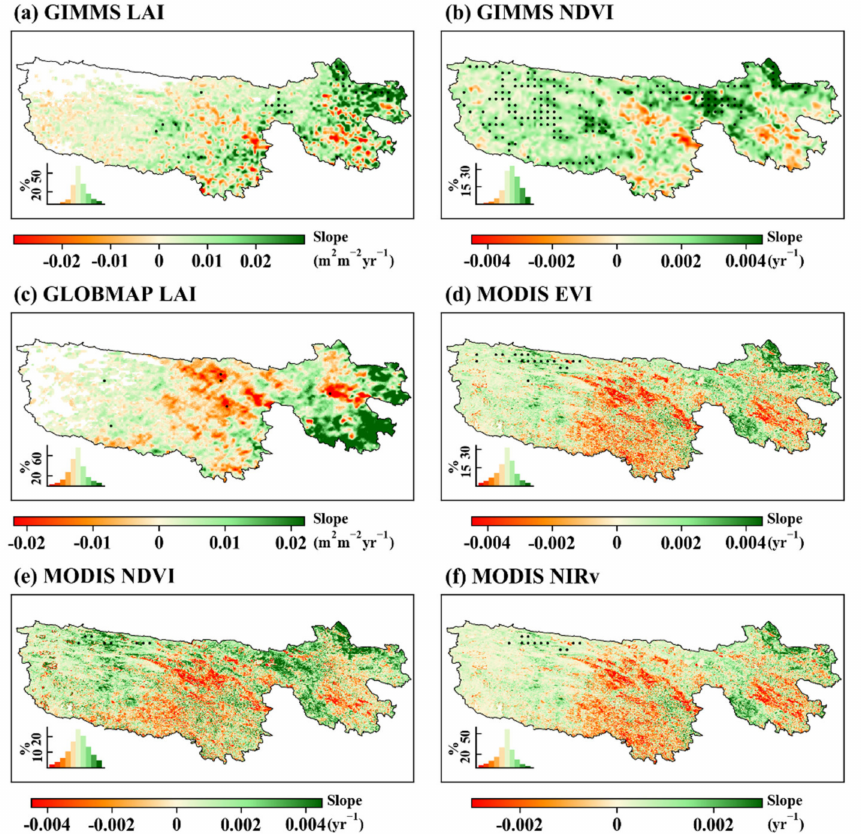
Figure 6. Trend of vegetation indices (VIs) in the TRSR from 2001 to 2016. ( a ): Global Inventory Modeling and Mapping Studies leaf area index (GIMMS LAI); ( b ): GIMMS Normalized Difference Vegetation Index (NDVI); ( c ): Global Mapping (GLOBMAP) LAI; ( d ): Moderate Resolution Imag- ing Spectroradiometer Enhanced VI (MODIS EVI); ( e ): MODIS NDVI; ( f ): MODIS near-infrared reflectance of vegetation (NIRv). The value frequencies are shown in the bottom left inset for each panel. The regions with black dots indicate that the trend is statistically significant at the 0.05